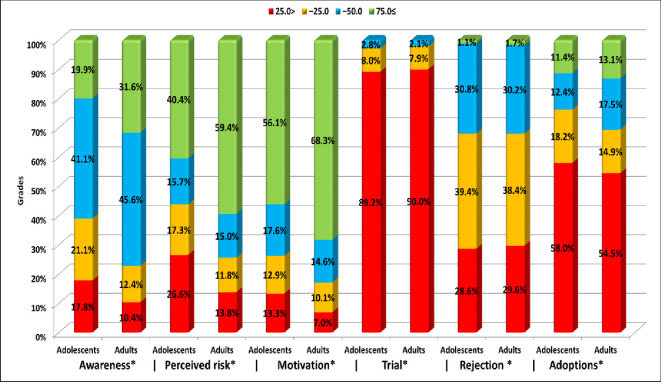
Differences between adults and adolescents in grading scores of levels of behavior development.